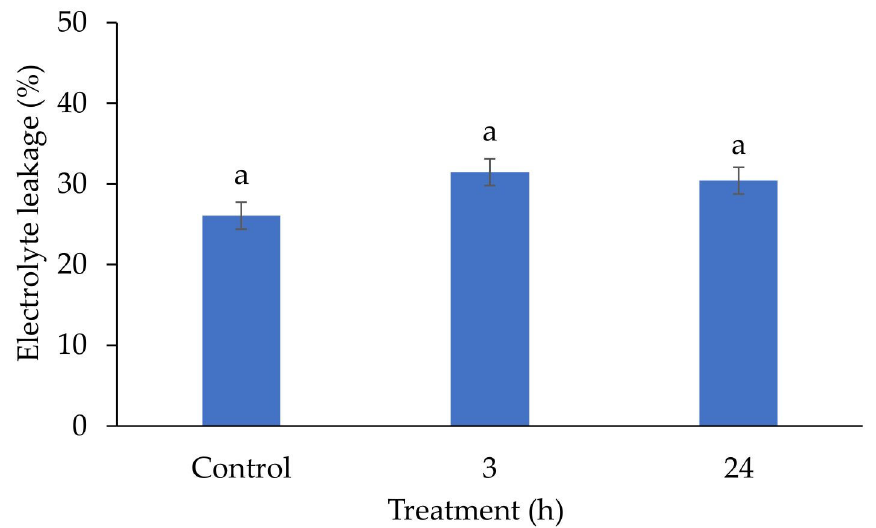
Figure 2. Electrolyte leakage of triticale ( × Triticosecale Wittm. ex A.Camus) seedlings irradiated with a helium-neon (He-Ne) laser by 3 and 24 h; mean ± SD (n = 10) values marked with di ff erent letters di ff er statistically according to Tukey’s test at p ≤